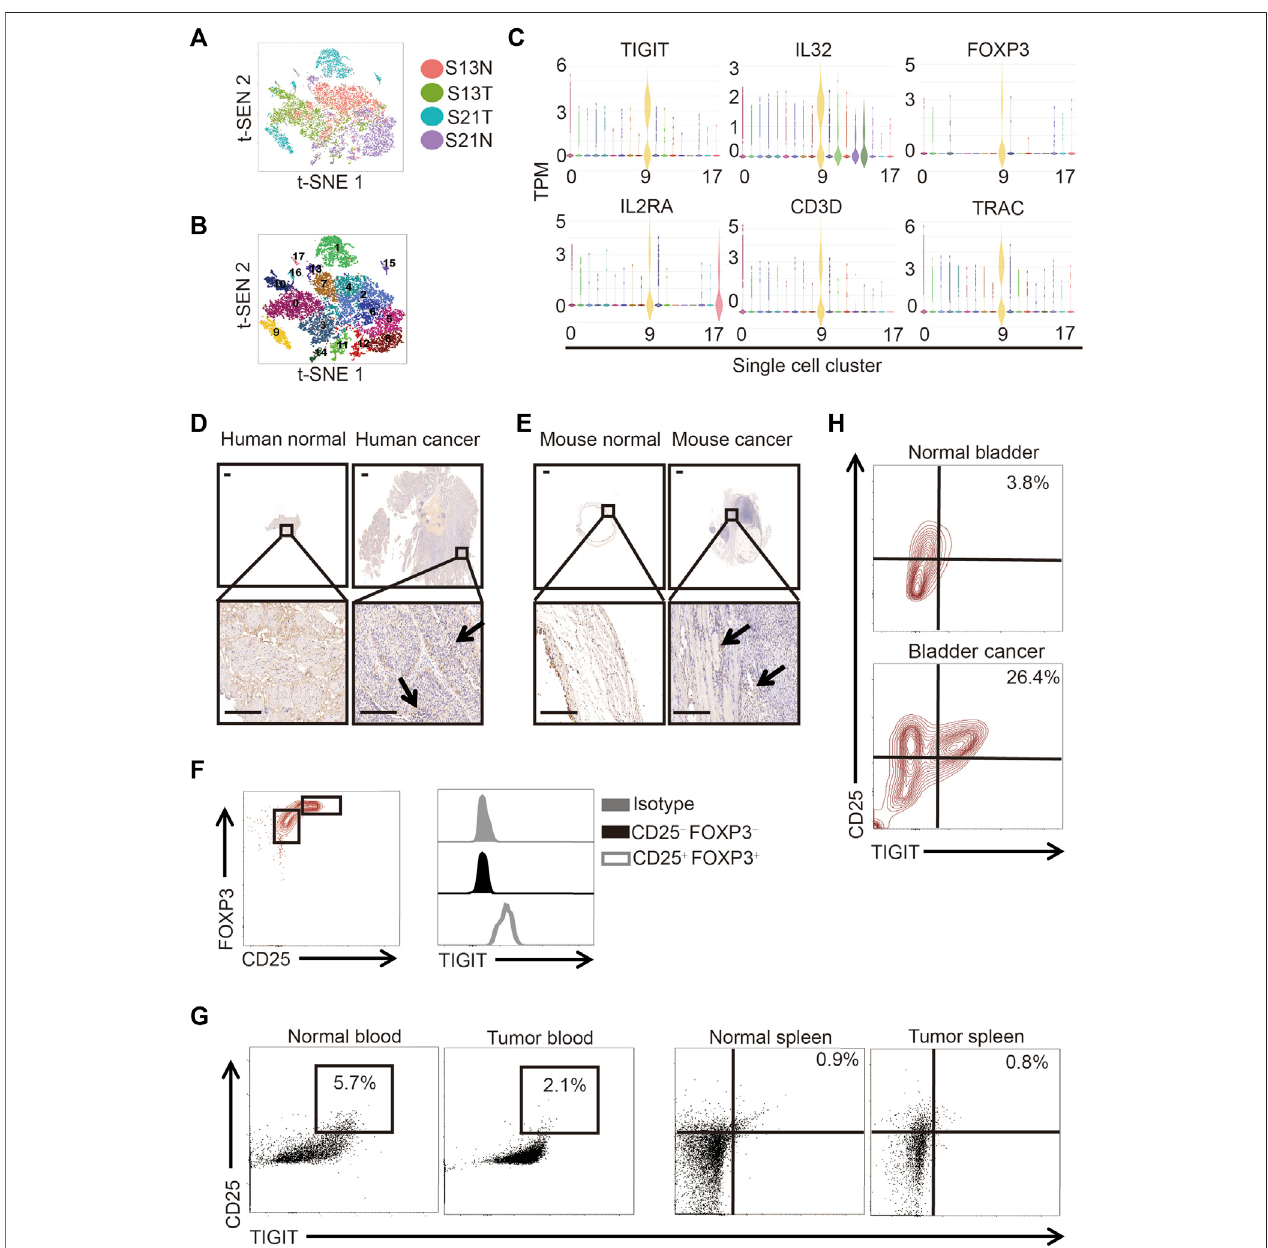
FIGURE 1 | TIGIT + Treg cells in bladder cancer tissues. (A) Schematic showing the single-nucleus RNA sequencing process. Samples of bladder tissues were surgicallyremoved.Singlecellswereobtainedfromcancerous(n (cid:1) 2)orparacancerous(n (cid:1) 2)bladdertissuesofpatientsandprocessedbyplate-basedscRNA-seq. (B) Two-dimensional t-distributed stochastic neighbor embedding (t-SNE) visualization from single-nucleus RNA sequencing showing the distribution of all nuclei. Eighteen major nuclear classes were identi fi ed. Each dot represents a single nucleus colored according to cluster assignment. Background is colored by major cell types (epithelialcells,Tcells,Bcells,endothelialcells, fi broblasts,stromalcells,umbrellacells,andsmoothmusclecells). (C) GeneexpressionforeachTIGIT+IL-32+IL2RA+ FOXP3+ CD3 + TRAC + single cell plotted as log2 counts per million. (D,E) Higher expressions of TIGIT in human (D) and murine (E) bladder cancer tissues. Immunohistochemistry images showing the expression of TIGIT in bladder tissues collected from different anatomical sites and groups of animals. Representative data from four independent experiments (n (cid:1) 5). Scale bar (cid:1) 1 mm. (F) Higher level of expression of TIGIT on the surface of Treg cells. Overlaid histogram plots showing the levels of expression of TIGIT in different CD4 + T-cell subsets. Data are representative of three independent experiments (n (cid:1) 6). (G) TIGIT + Treg cells in the blood and spleen of mice with bladder cancer. The numbers in the dot plots represent the frequencies of TIGIT + Treg cells. Data are representative of three independent experiments(n (cid:1) 8). (H) HigherfrequenciesofTIGIT+Tregcellsinmurinebladdercancertissues.Thenumbers inthedotplotsrepresentthefrequenciesofTIGIT+Treg cells. Data are representative of four independent experiments (n (cid:1) 8).